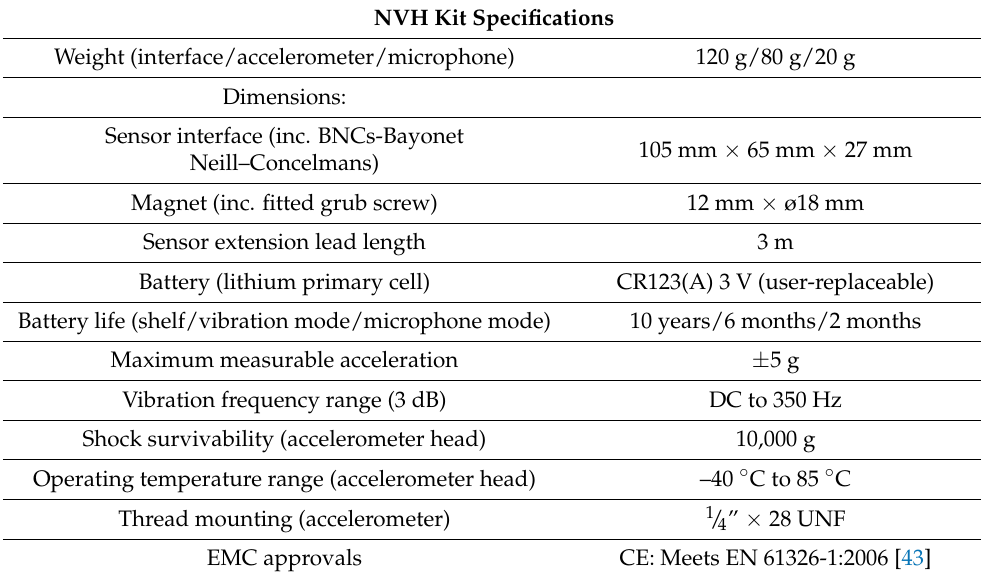
Table 1. The available parameters of the measurement device based on the official datasheets.